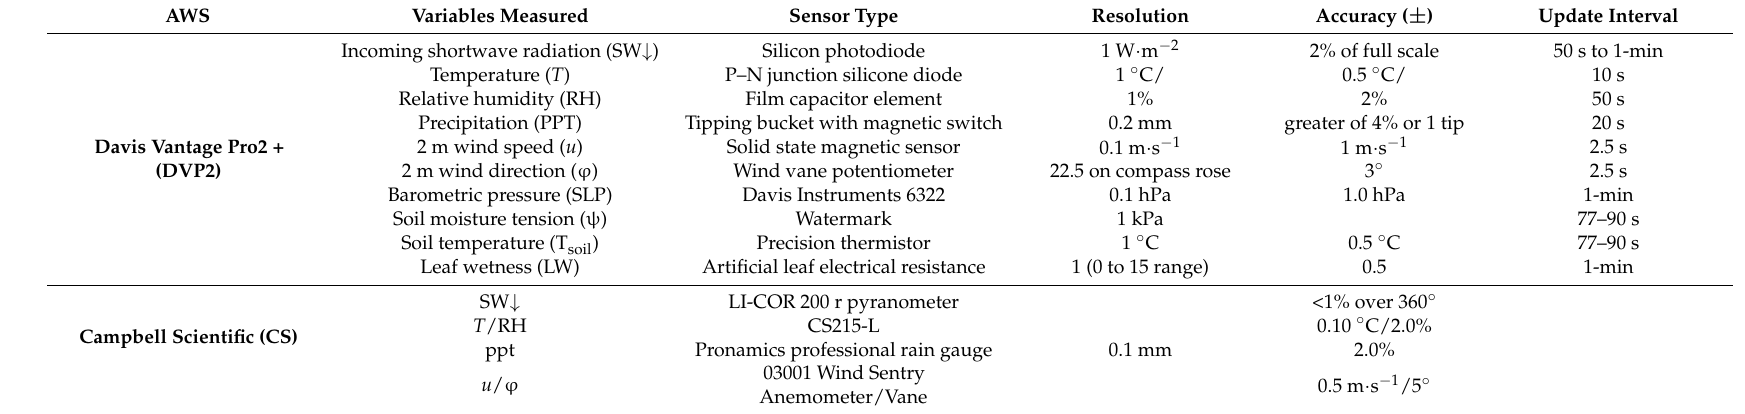
Table 2. The automatic weather stations types, weather variables measured, sensor type, measurement resolution, sensors’ measurement accuracy, and data update interval of the sensors [47]. Key: AWS—automatic weather station; SLP—sea-level